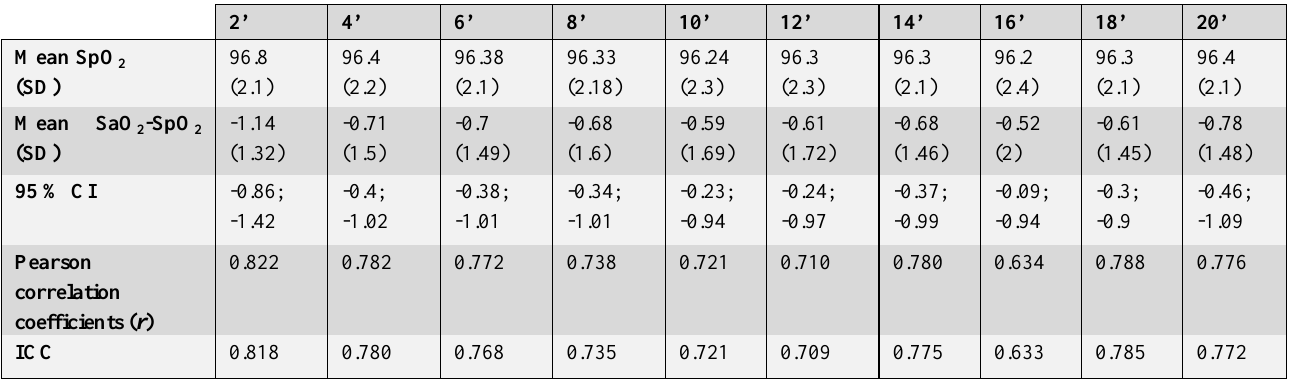
The upper row shows the time in minutes. SpO